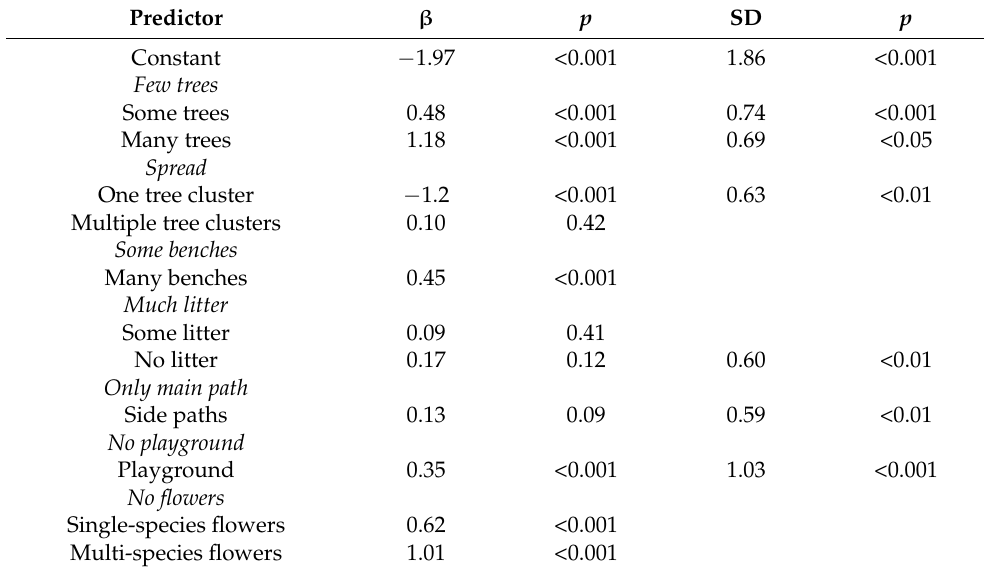
Table 3. Results of mixed logit model. The predictors in italics indicate the base level of each attribute. Predictor β p SD p Constant −